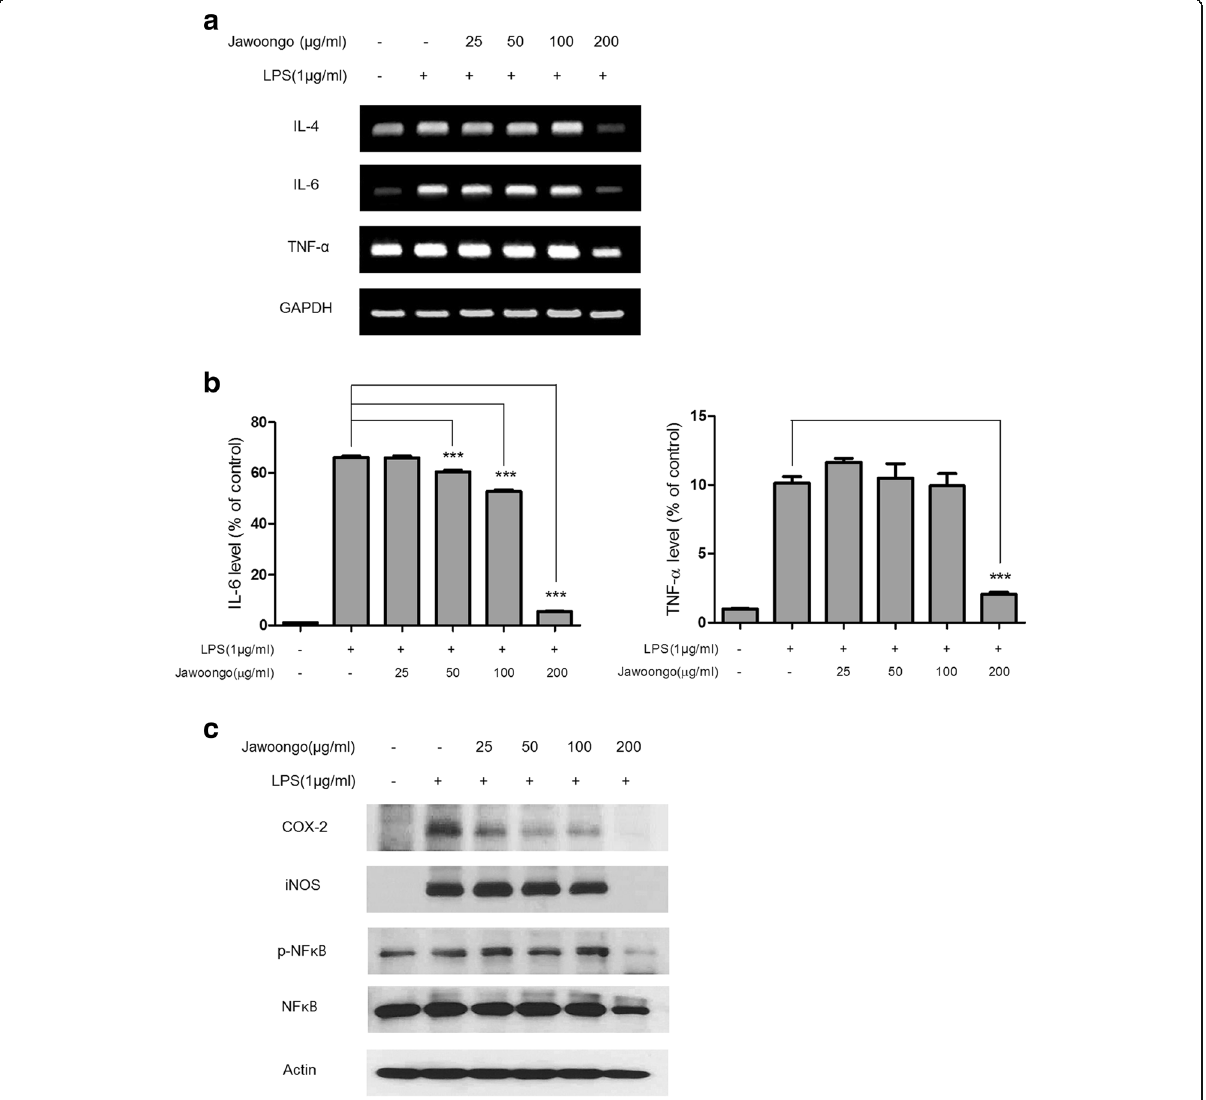
Fig. 9 Effects of Jawoongo on cytokine expression in splenocytes. Splenocytes were stimulated with LPS (1 μ g/ml) and then treated with different concentrations of Jawoongo (25 – 200 μ g/ml) for 24 h. IL-4, IL-6 and TNF- α mRNA expression was measured by RT-PCR ( a ). The culture medium of the cells was harvested, and IL-6 and TNF- α cytokine levels were measured by ELISA ( b ). Whole cell lysates were analyzed by Western blotting ( c ). The data were presented as mean ± SEMs ( n = 8 mice/group). * P < 0.05, ** P < 0.01 and *** P < 0.001 as compared to LPS-stimulated group,